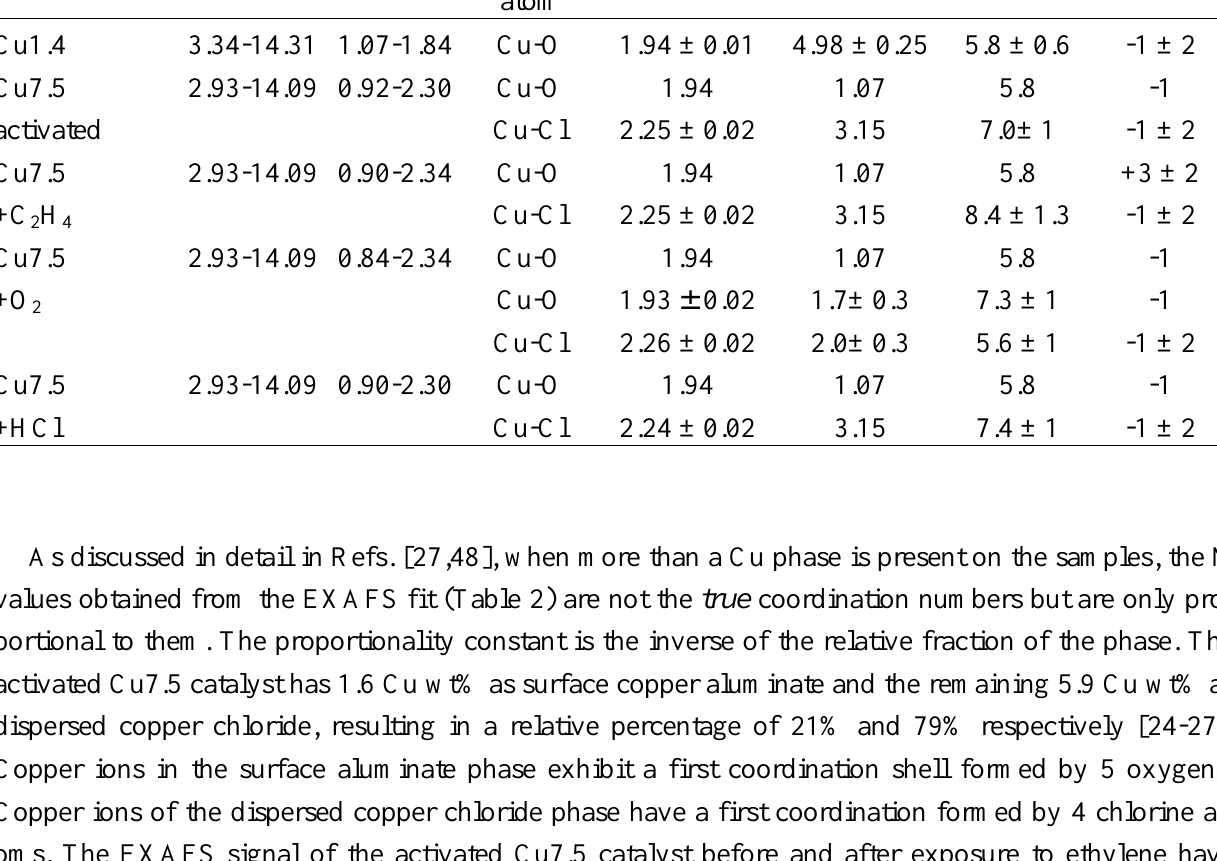
O supported 2 3